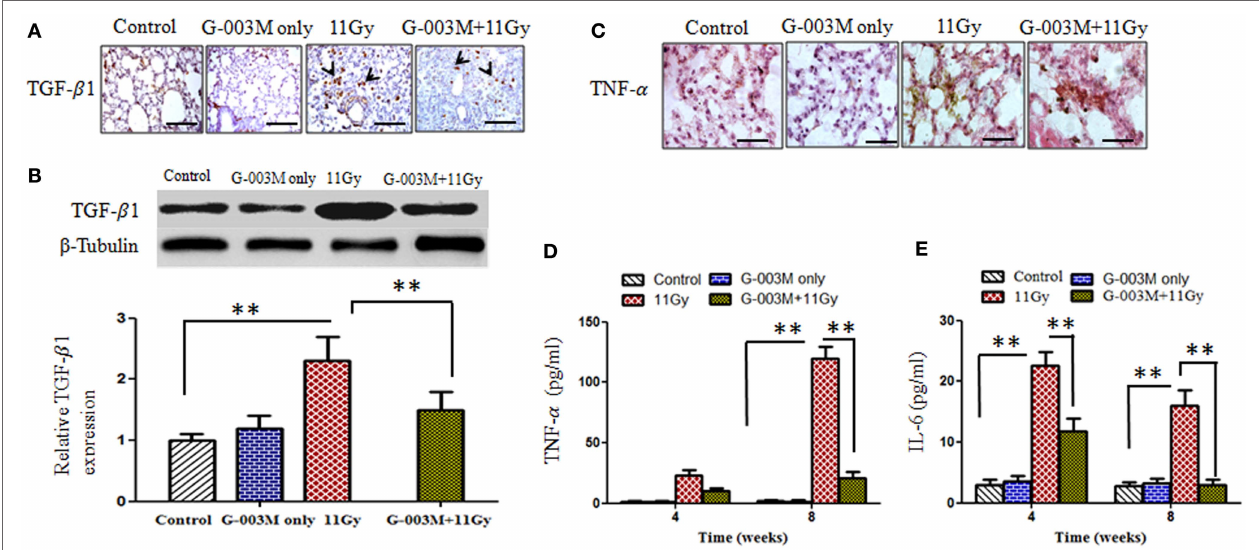
FigUre 8 | Effect of G-003M on expression of pro-inflammatory and fibrogenic cytokines. (a) Immunohistochemical expression of transforming growth factor- β 1 (TGF- β 1) (arrows) in lungs of differentially treated mice (400 × ). Scale bar 50 µm. (B) Western blotting of TGF- β 1 at 8 weeks postirradiation. Densitometry analysis represents TGF- β 1 expression normalized to β -tubulin. (c) Immunohistochemical expression of tumor necrosis factor- α (TNF- α ) in lungs of experimental mice (1,000 × ). Scale bar 10 µm. (D) Histogram representing TNF- α level in bronchoalveolar lavage fluid (BALF) of experimental mice. (e) Bar diagram indicating interleukin-6 (IL-6) level in BALF of experimental mice. Data are represented as means ± SEM from six mice for each group. ** p <